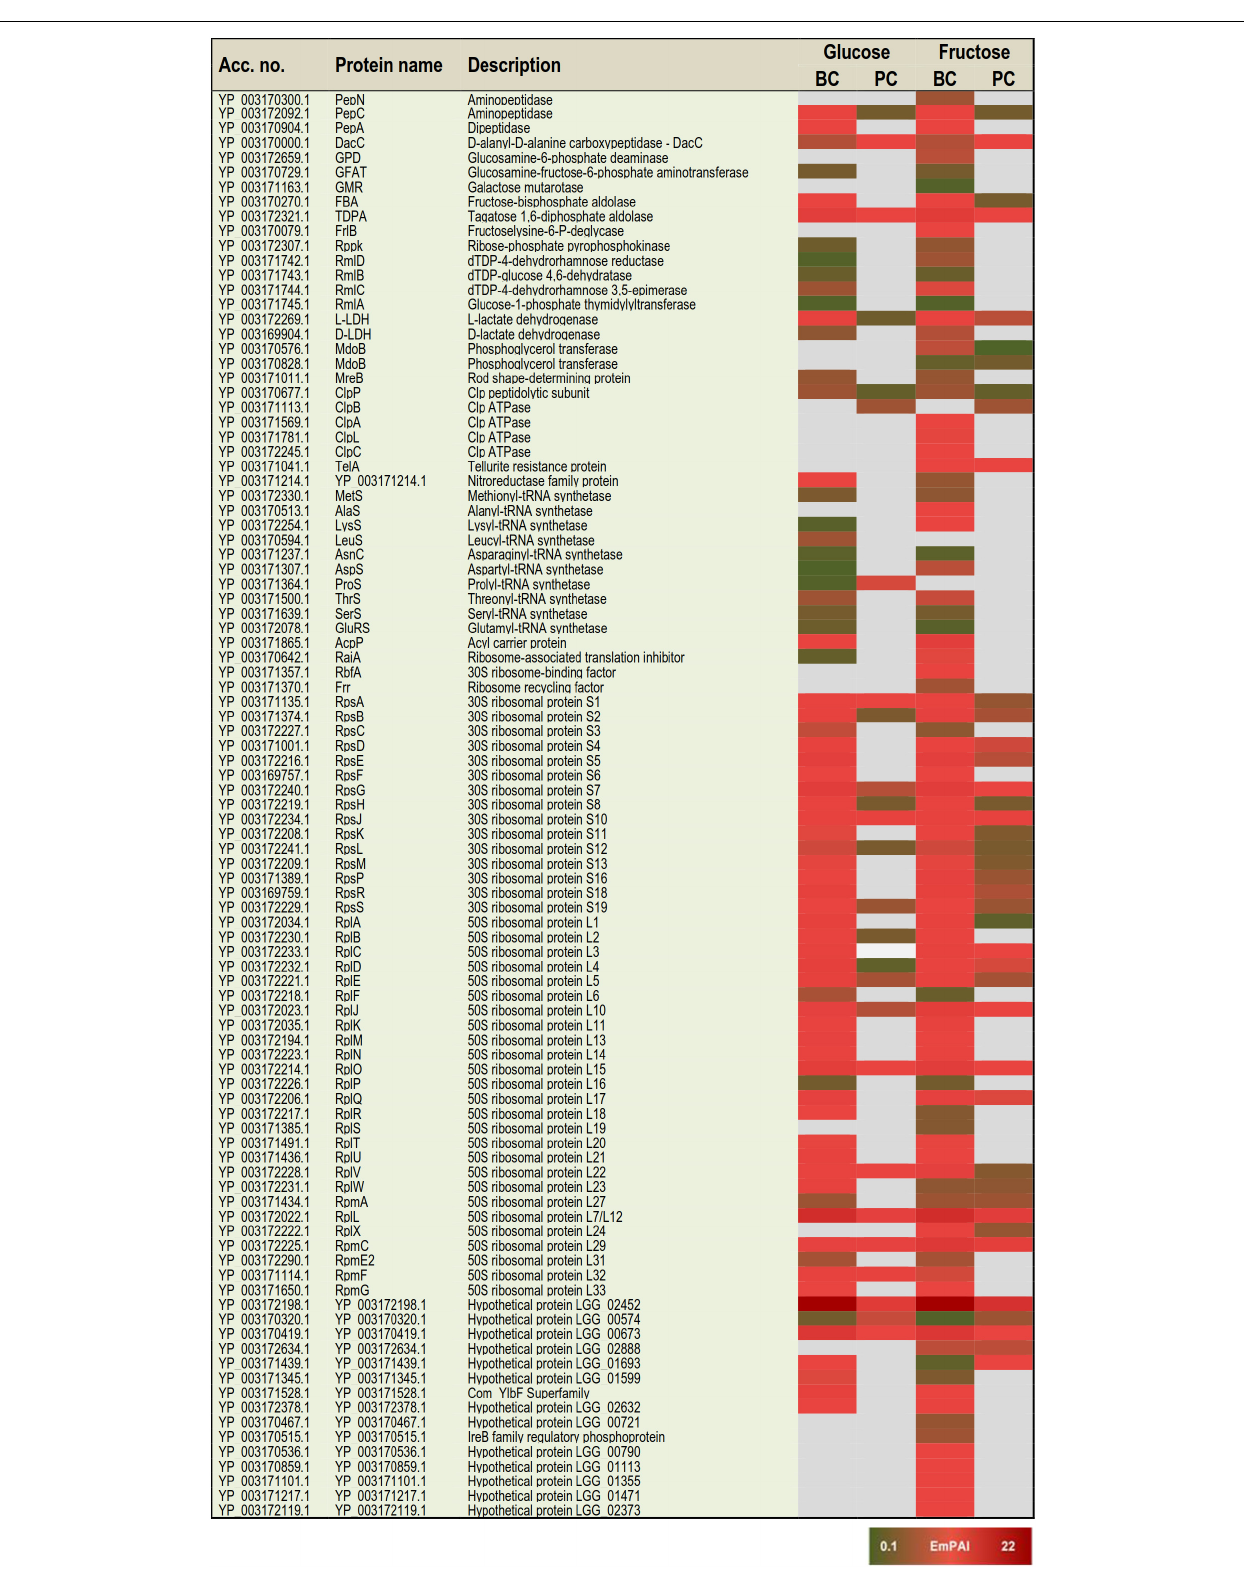
Frontiers in Microbiology |